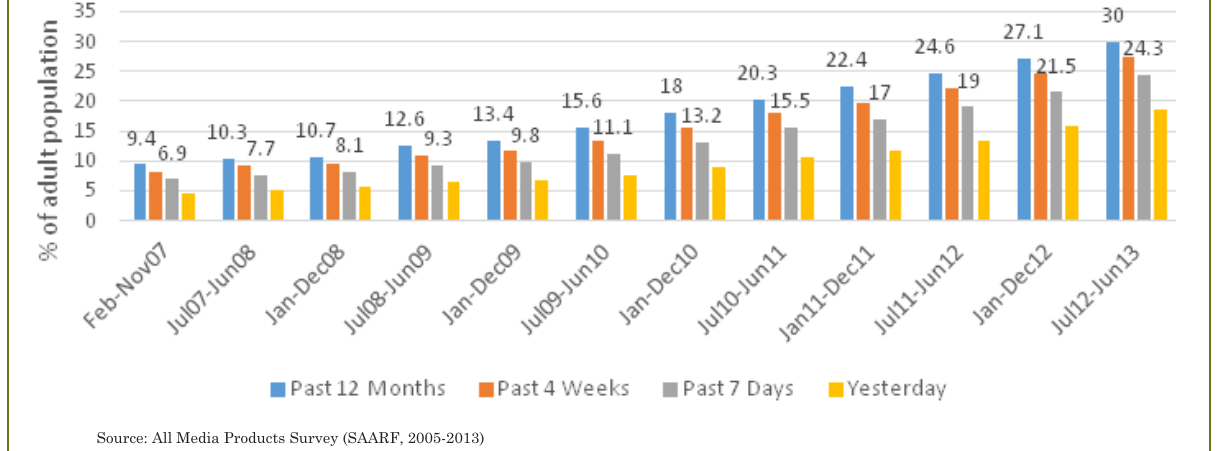
FIGURE 6: INTERNET USE BY SOUTH AFRICAN ADULTS (AMPS, 2007-2013)